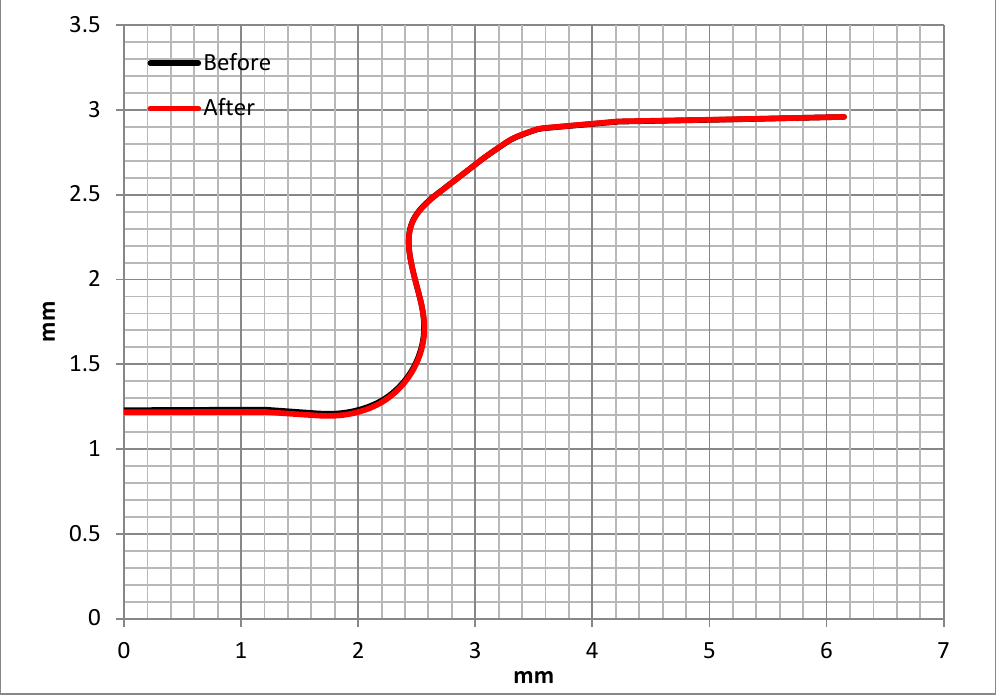
Figure 10: Springback analysis for upper sheet lower face and lower sheet upper